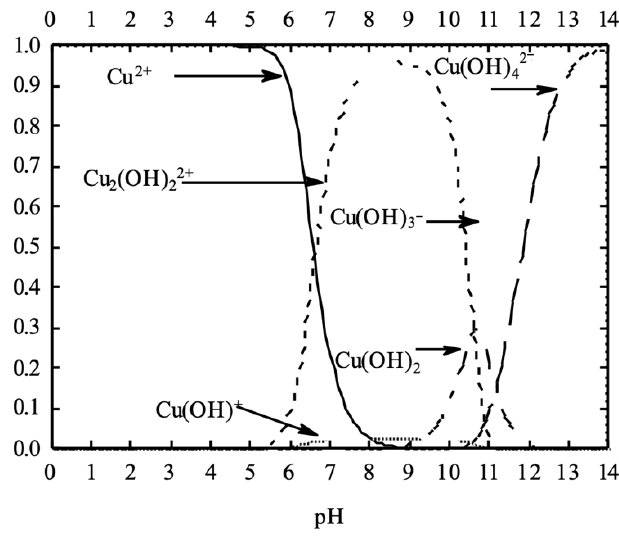
Figure 4. Cu (II) species distribution diagram as a function of pH. Hence, Cu (II) adsorption on marble sludges may be produced by: (i) intercalation of the metal cation between CaCO 3 layers and (ii) the formation of surface carbonate com- plexes.